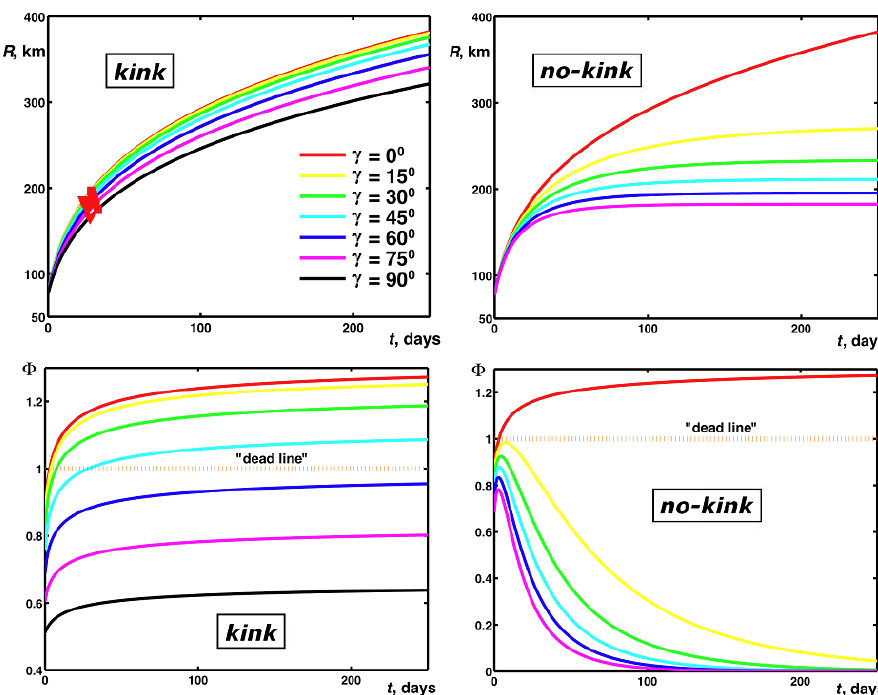
Fig. 4 . Base eddy radius R (upper panels) and mass flux ratio Φ (lower panels) as functions of time for different values of γ : Concave I case (left) and analogous no-kink ZNa model (right). For the kink model, γ indicates the angle of the eastern shoreline segment; for the no-kink model γ indicates the angle of single-segment slant. The straight dotted “dead lines” (lower left panels) show the limit of q = 0 , Φ = 1 . Red triangles and squares (upper left) denote the lower and upper boundaries of the detachment period for β= 2.3 × 10 − 11 m − 1 s − 1 , α= 1 , h 0